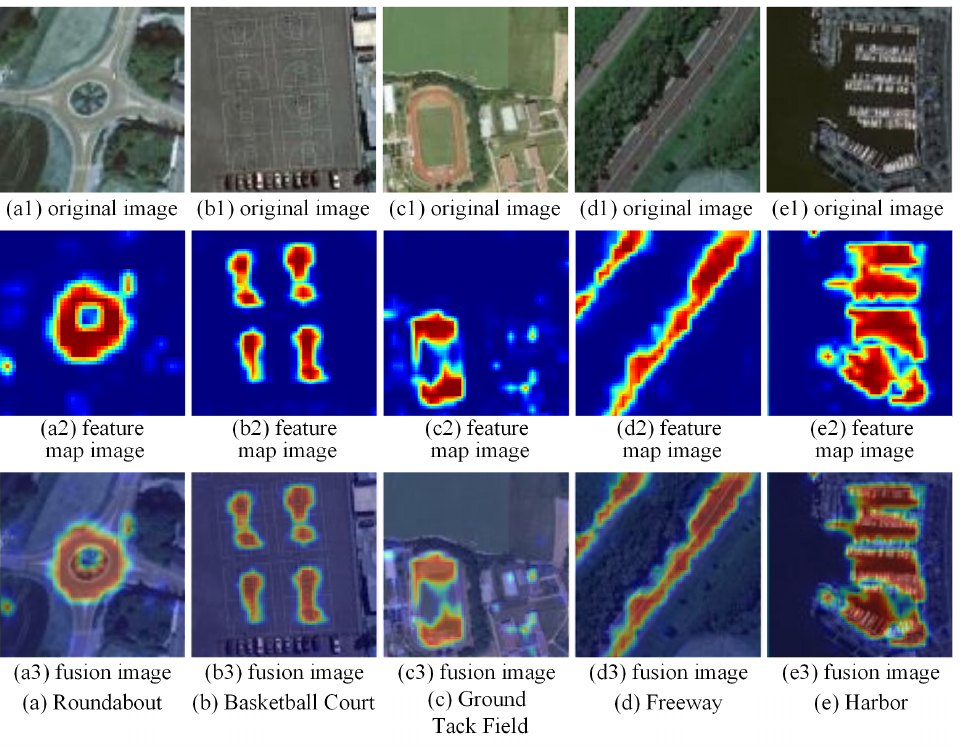
Figure 10. Visualization of some samples in the NWPU-RESISC45 dataset, from top to bottom is the original image, the class-related attention feature map of the image, and the fusion image of the